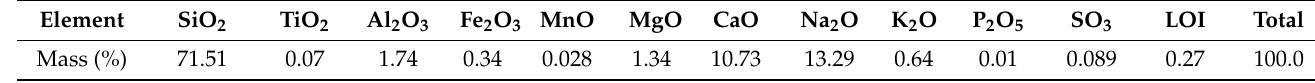
Table 1. Oxide composition of the glass powder used in this